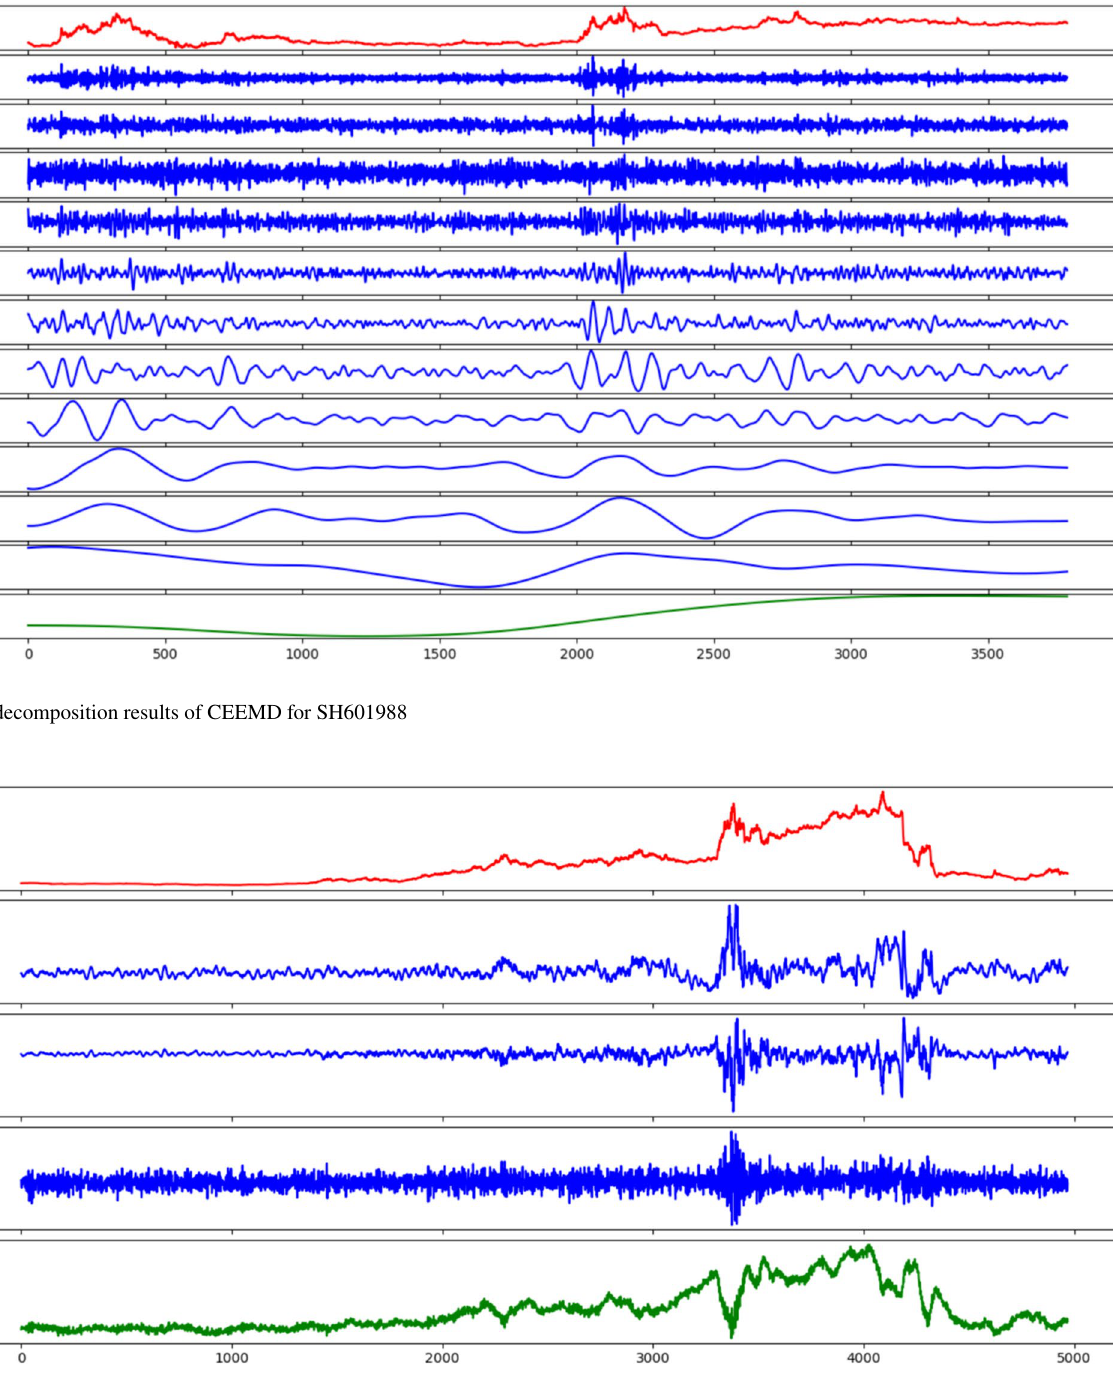
Fig. 8 The results of ICA for